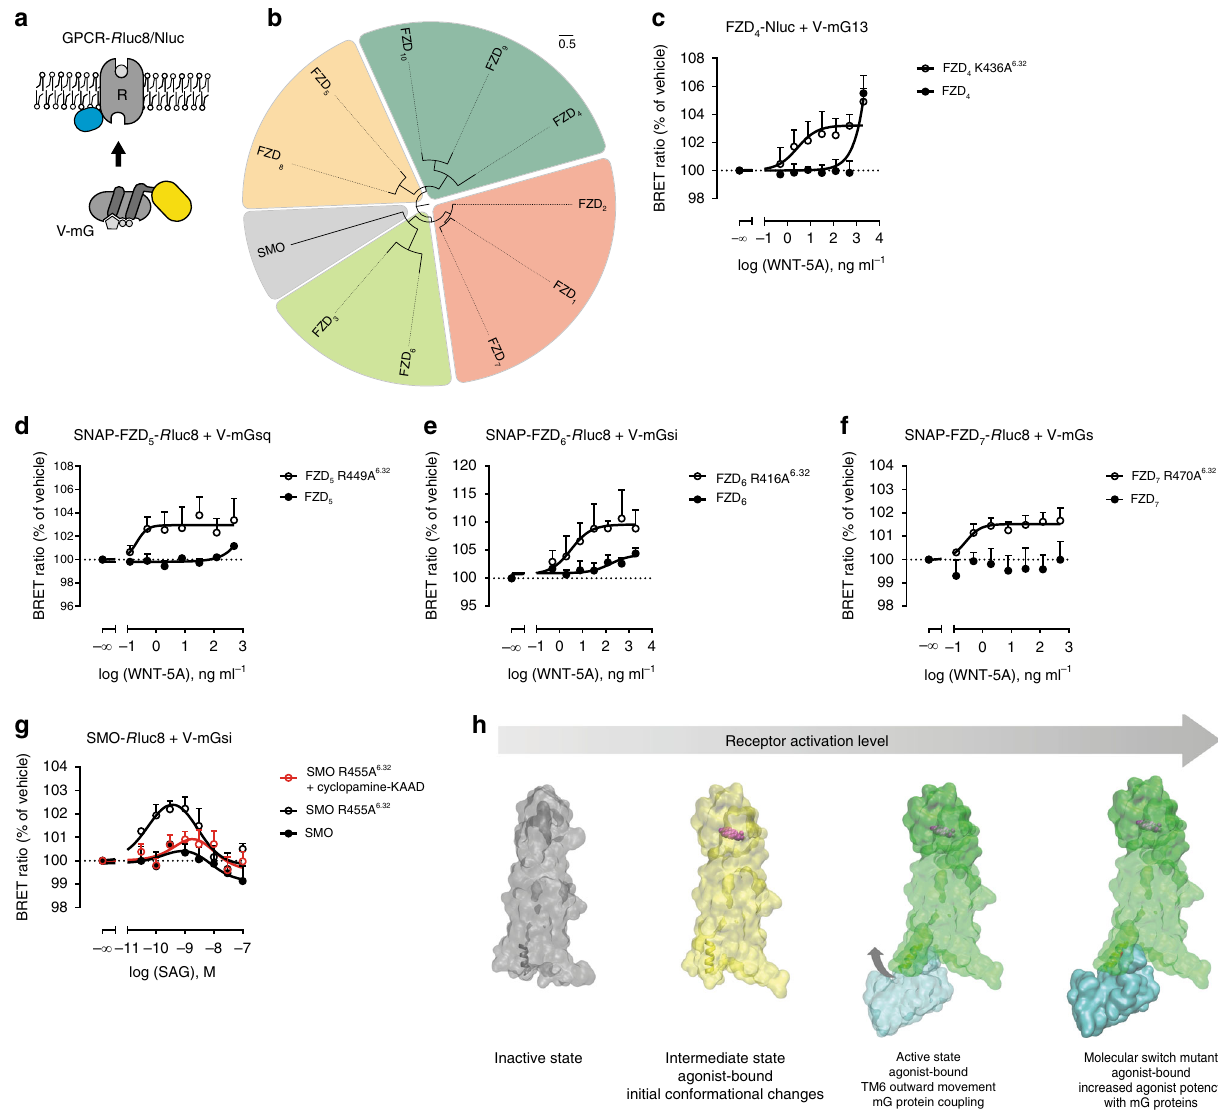
Fig. 5 Switch mutations at position 6.32 of Class F receptors increase agonist potency. a Illustration depicts the experimental setup wherein luciferase- tagged Class F receptors (R) are expressed at the plasma membrane and validated Venus-tagged mG proteins are localized to the cytosol 24 . Relying on excitation from proximity to the luciferase (donor), the Venus-tagged mG protein (acceptor) fl uoresces only when the receptor is in its active conformation. b Maximum-likelihood phylogenetic tree of human FZD and SMO paralogs, with the four major FZD clusters and SMO color-coded. Branch lengths are given in amino-acid substitutions per site. c – g BRET experiments in HEK293 cells transiently expressing representatives of Class F with mG proteins: c FZD 4 /mG13 ( n = 6), d FZD 5 /mGsq ( n = 5), e FZD 6 /mGsi (wild type n = 7; R416A 6.32 n = 6), f FZD 7 /mGs ( n = 8), and g SMO/mGsi ( n = 6). Wild-type receptor ( fi lled circle) and molecular switch mutants (open circle) were compared in parallel and receptor surface expression was measured by bystander BRET and fl ow cytometry (Supplementary Figure 6). Cells were stimulated with the indicated concentrations of recombinant WNT-5A or SAG and the normalized BRET ratio of Venus to R luc8/Nluc was measured. In g , effects of SAG alone were compared to increasing concentrations of SAG in the presence of the inverse agonist cyclopamine-KAAD (100 nM; red open circle). Data are represented as mean ± s.e.m. h Summary scheme illustrating the activation states of Class F receptors in the absence and presence of receptor-activating ligands, mG protein and the R/K 6.32 mutation. Only the combination of agonist and mG protein can stabilize a fully active state. The receptor models in the active state are a fusion of the full-length SMO structure (PDB ID 6D35) and the lower end of TM6 of the adenosine A 2A receptor in complex with a mG protein (PDB ID 5G53 20